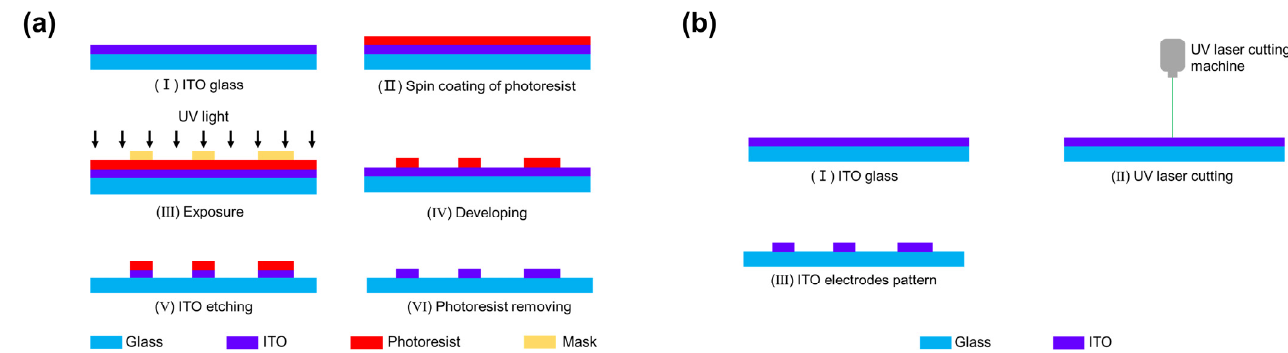
Figure 2. ( a ) Diagram of the photolithography microfabrication process for the ITO electrodes. ( b ) Diagram of the UV laser cutting fabrication process for the ITO electrodes.